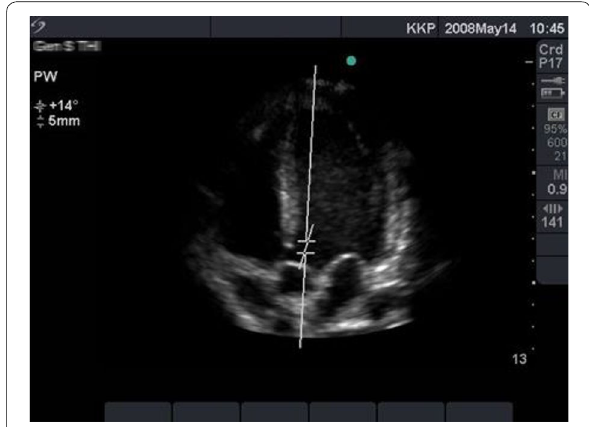
Fig. 4 Apical 5 chamber view with pulsed wave Doppler sample